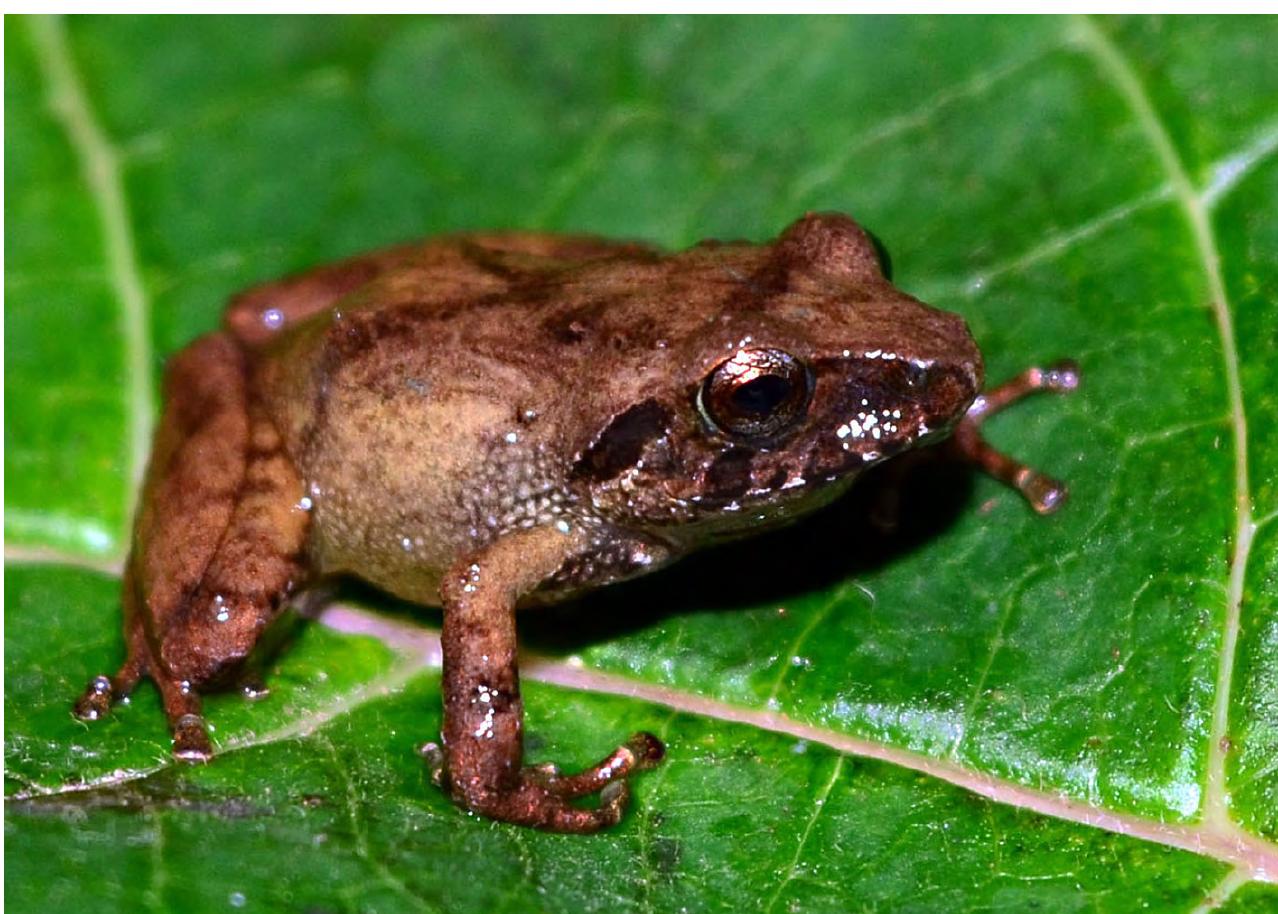
Figure 2. A juvenile female of Pristimantis carranguerorum from Junín, Cundinamarca (ICN 55897) with snout–vent length (SVL) of 16.8